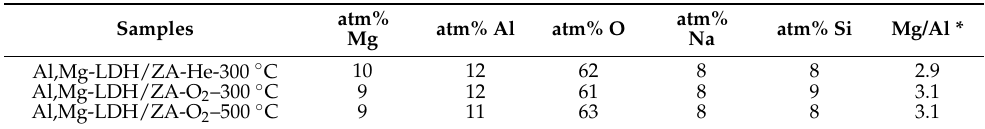
Table 2. Chemical analysis of the LDH/zeolite A composite after different treatments and rehydration with H 2 O vapor.